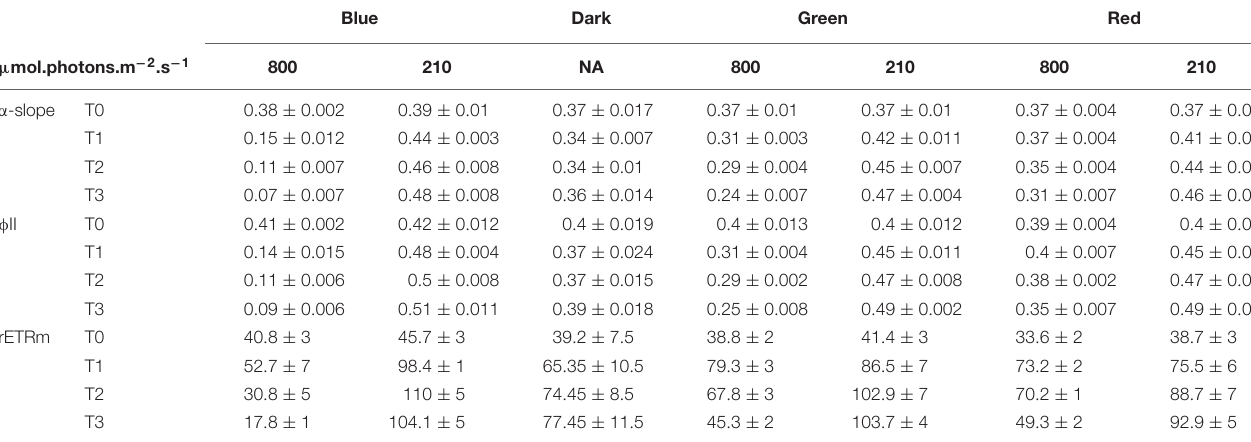
TABLE 1 | Photosynthetic parameters and φ II 1 values obtained from rapid light curve fitting of φ II (E) within the non-migrational biofilm. Blue Dark Green